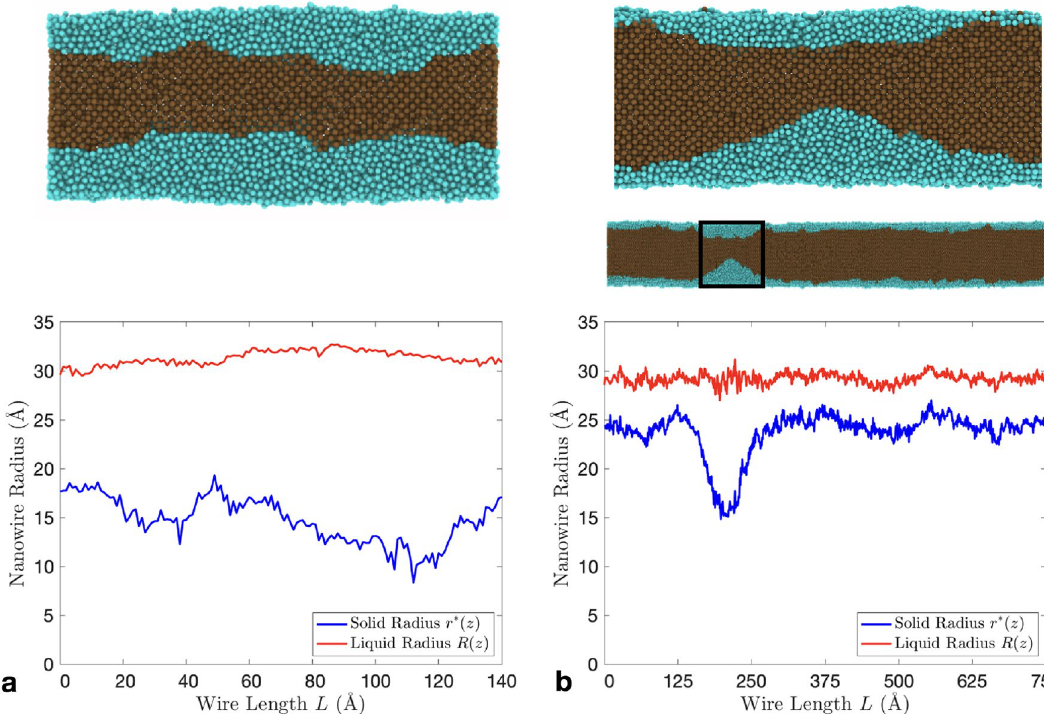
Figure 3. A plot showing the solid radius r ∗ ( z ) for two surface melted nanowires both of radius R 0 ≈ 30 Å and lengths 140 and 750 Å from ( a )–( b ) respectively. Solid blue lines represent the radius of the solid-liquid interface, while the solid red lines indicate the liquid interface. The solid atoms are coloured brown (darker) and the liquid atoms are coloured blue (lighter). The snapshots of the nanowires in ( a ) and ( b ) are both right before the solid core breaks apart. In ( a ) the size of the liquid nucleus is nearly half the nanowire radius, whereas in ( b ) the liquid nucleus only takes up a small portion of the total nanowire